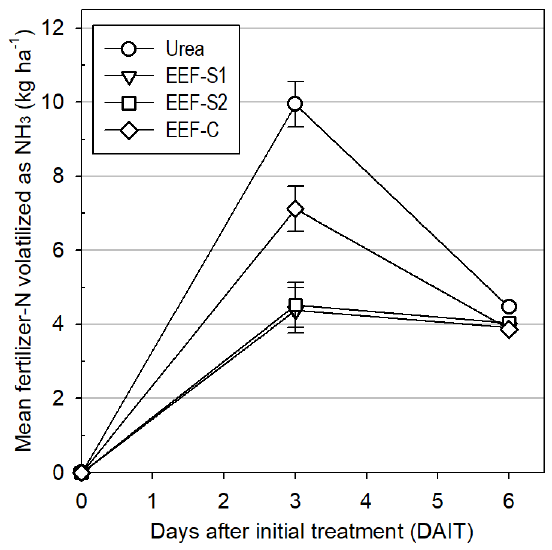
Figure 1. Mean ammonia volatilization by days after initial treatment (DAIT) and fertilizer; EEF-S1, stabilized urea (UFLEXX), EEF-S2, stabilized urea (UMAXX), EEF-C, coated-urea/urea blend (STA-GREEN). Where present, error bars designate the least significant difference (LSD) at a 0.05 α-level.